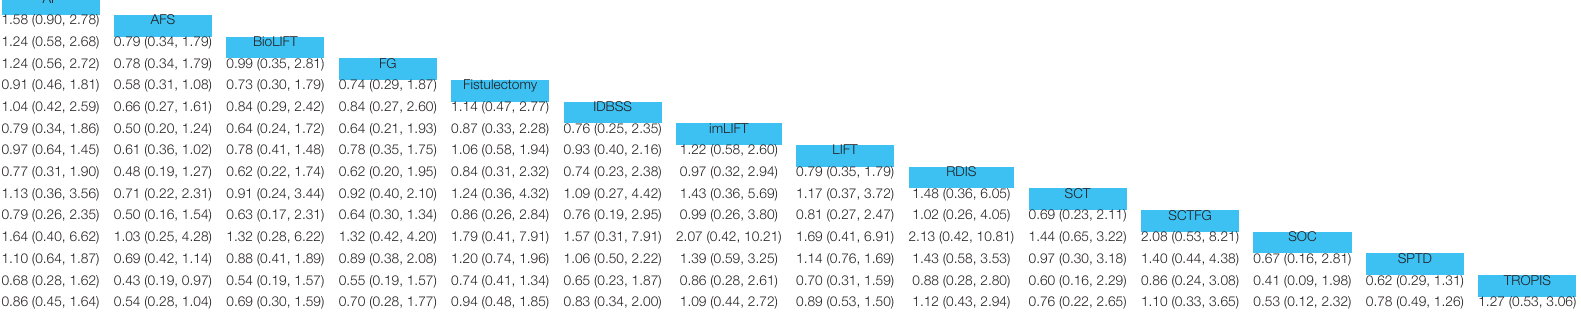
TABLE 2 | Network meta-analysis results of cure rate (RR, 95% CI).